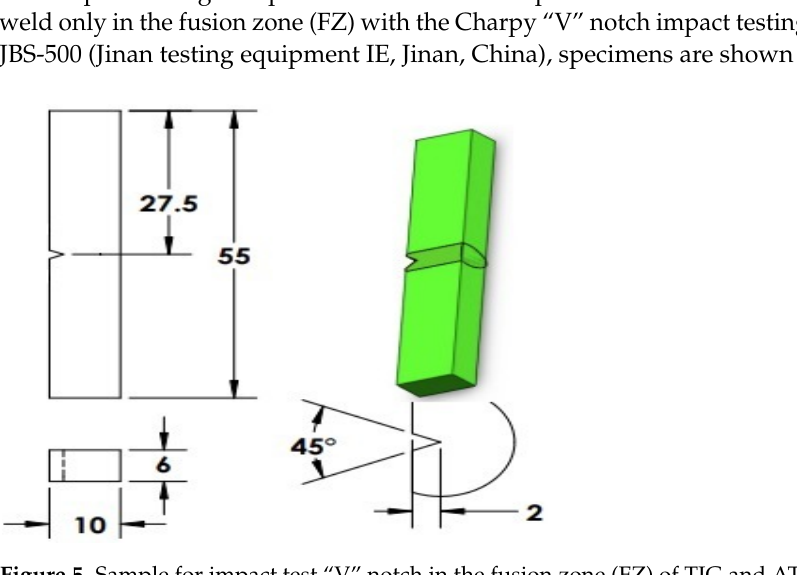
Figure 5. Sample for impact test “V” notch in the fusion zone (FZ) of TIG and ATIG Welded.